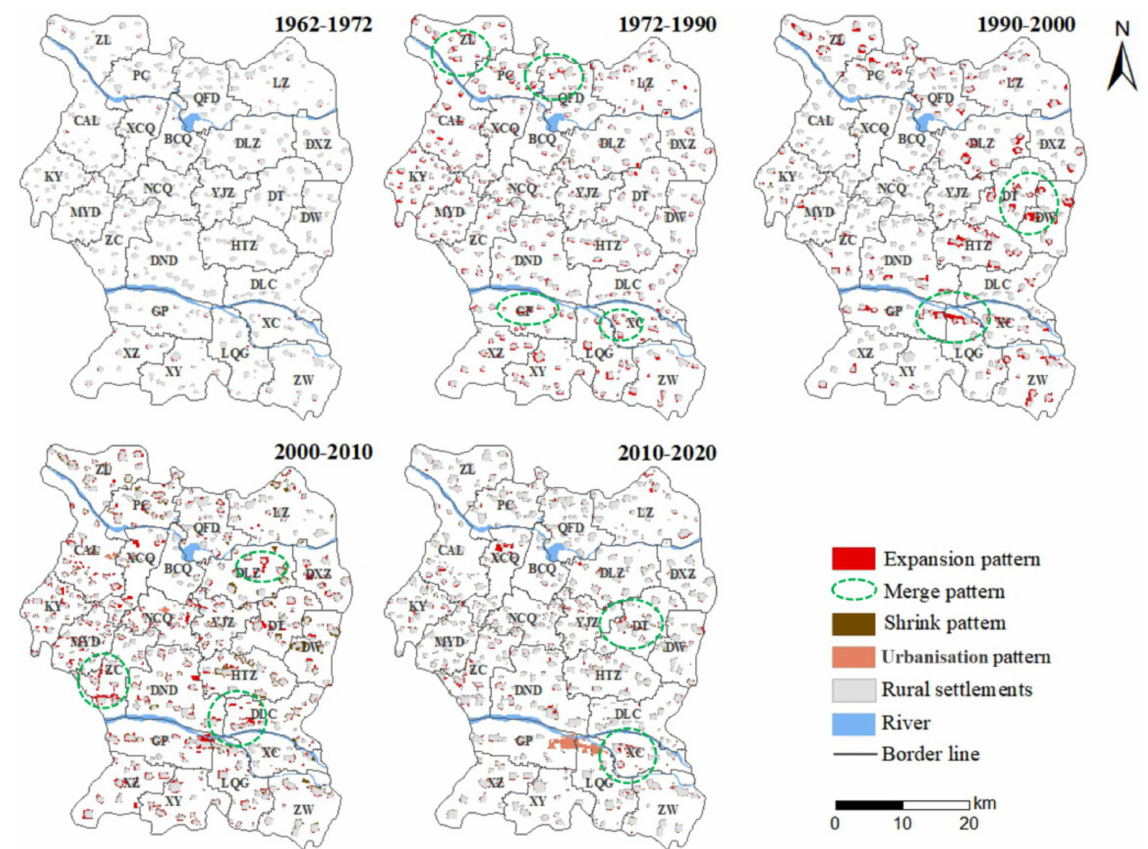
Figure 6. Change pattern of rural settlements in Dingzhou, China from 1962 to 2020. Note: NCQ: